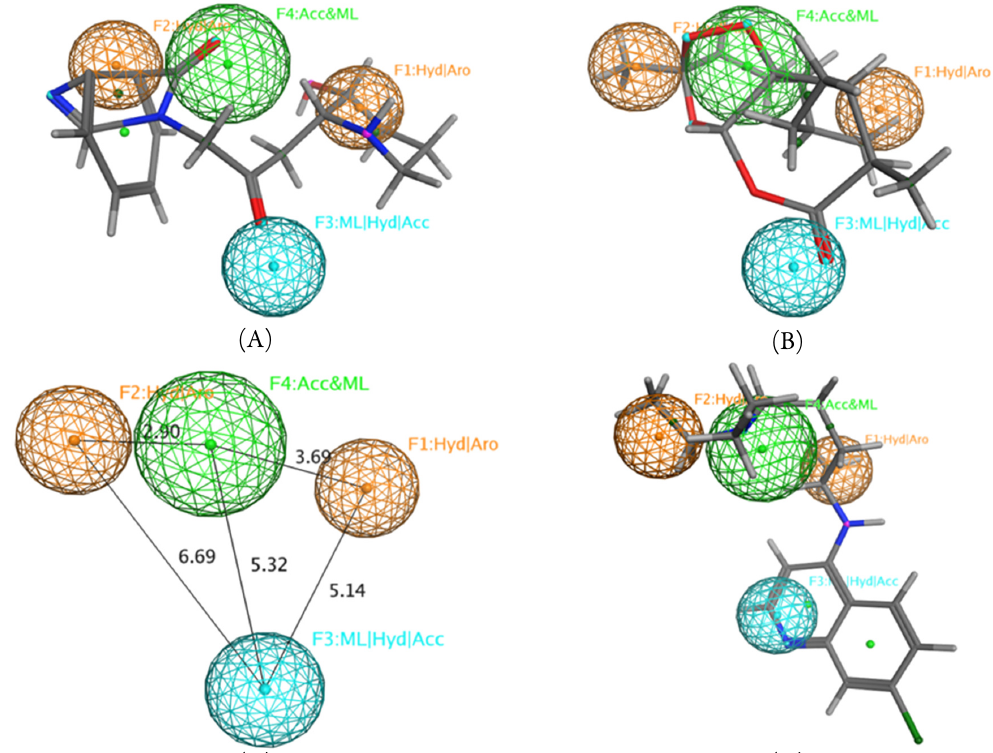
Figure 4. Pharmacophore model and its mapping to representative compounds. (A) The topological features of the model: the cyan contour represents metal ligator cum hydrophobic region cum hydrogen bond acceptor (ML/Hyd/Acc), green contour represents hydrogen bond acceptor cum metal ligator (ACC/ML), orange contour represents hydrophobic aromatic ring (Hyd/aro) features. (B) Chloroquine mapped with the model; (C) Febrifugine mapped with the model. (D) Artemisinin mapped with the